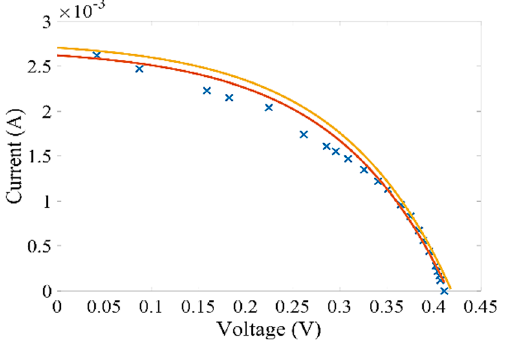
Figure 15. Experimental data acquired ( x ), characteristic curve that approaches the experimental data ( --- ), and simulated characteristic curve ( --- ), for the 650 nm filter.